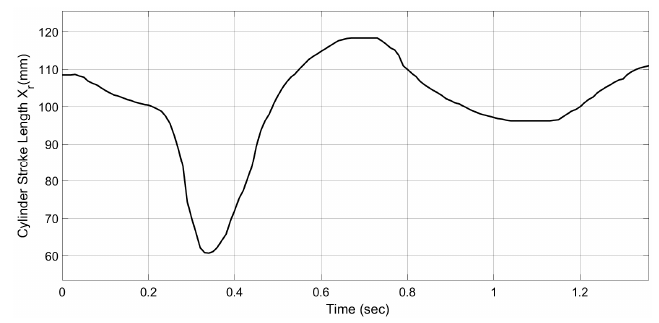
Figure 3. Displacement of the cylinder rod 𝑥 (cid:3045) during a gait cycle.